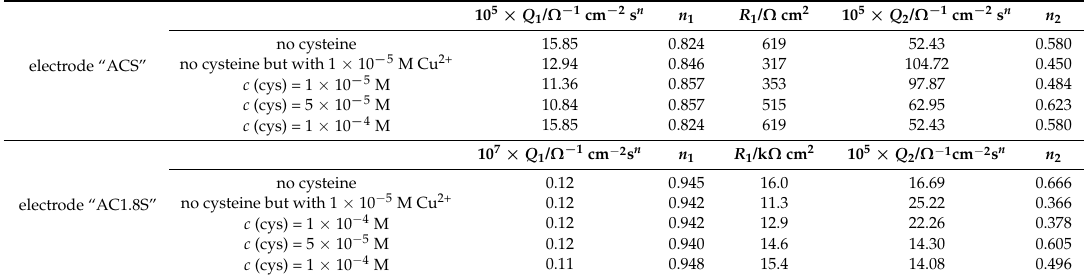
Table 2. Impedance parameters for electrodes “ACS” and “AC1.8S” (spectra recorded at pH 7), determined using the equivalent circuit, are presented in Scheme